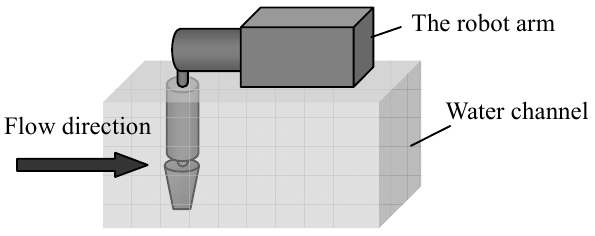
Fig. 9 Experimental setting to measure steady fluid